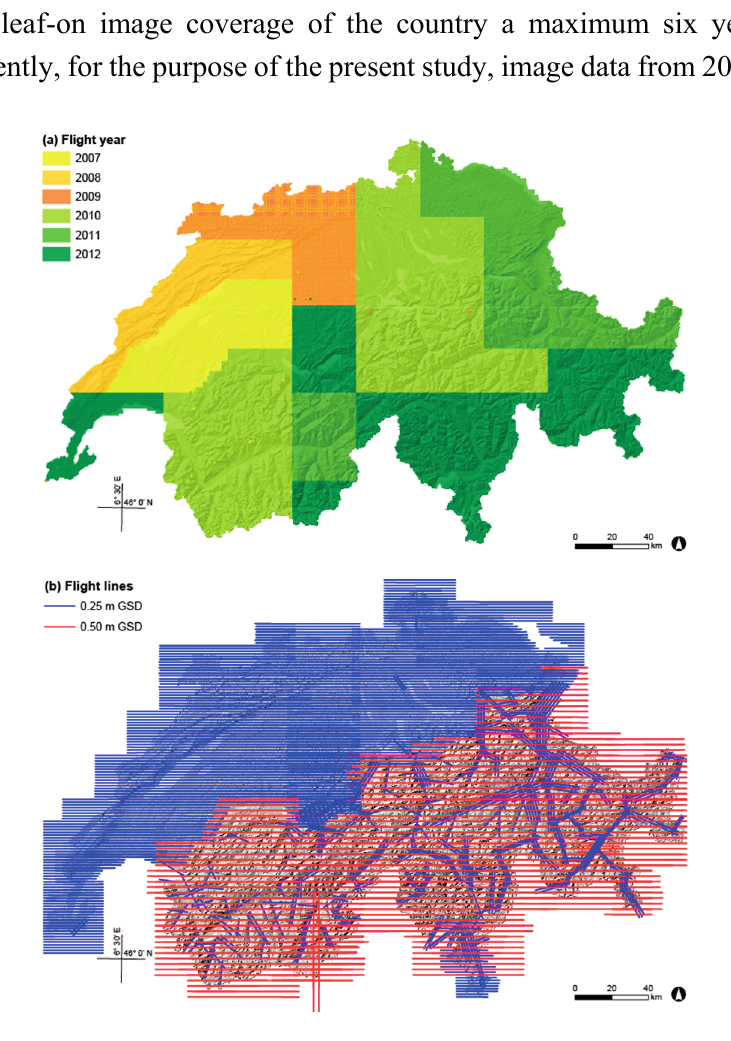
Figure 1. Image data used: ( a ) Coverage of ADS40/ADS80 images acquired in 2007–2012, ( b ) flight lines for the image acquisition for the entire of Switzerland. The imagery was acquired with a GSD of 0.25 m at lower altitudes ( denser flight lines ) and a GSD of 0.50 m at higher altitudes in the mountainous regions ( less dense flight lines